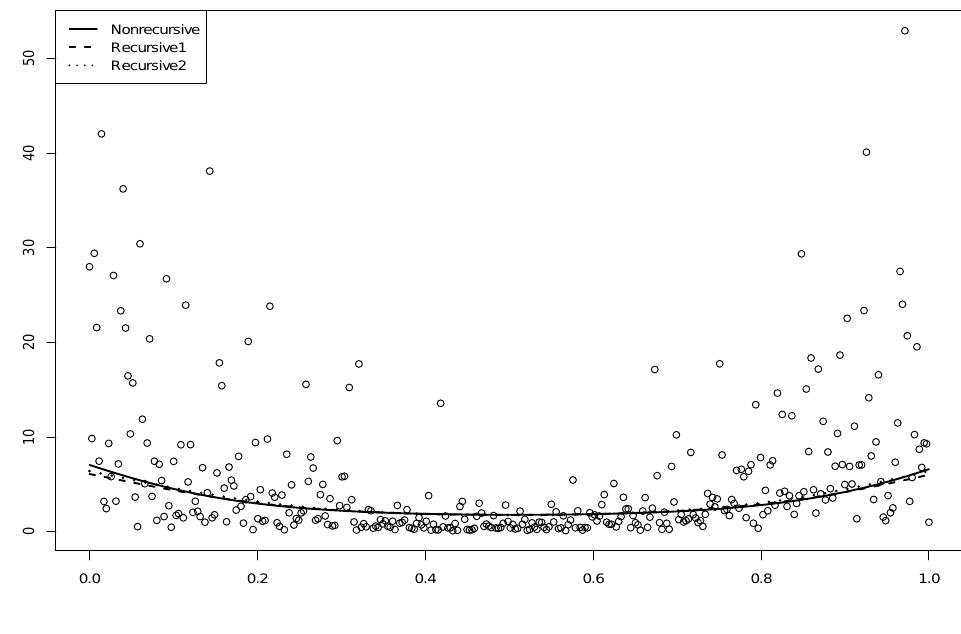
Figure 2: Qualitative comparison between three kernel relative regression estimators; non-recursive correspond to the estimator (5) using the proposed plug-in bandwidth selection (17), Recursive 1 correspond to the estimator (4) using the proposed plug-in bandwidth selection (14) and the stepsize ( γ n ) = (cid:0) n −1 (cid:1) , Recursive 2 correspond to the estimator (4) using the proposed plug-in bandwidth selection (14) and the stepsize ( γ n ) = (cid:0) h n / (cid:2)(cid:80) n log (cid:0) 0.5 + 40( x − 0.5) 2 (cid:1) , X ∼ U (0, 1) and ε ∼ N (0, 1)